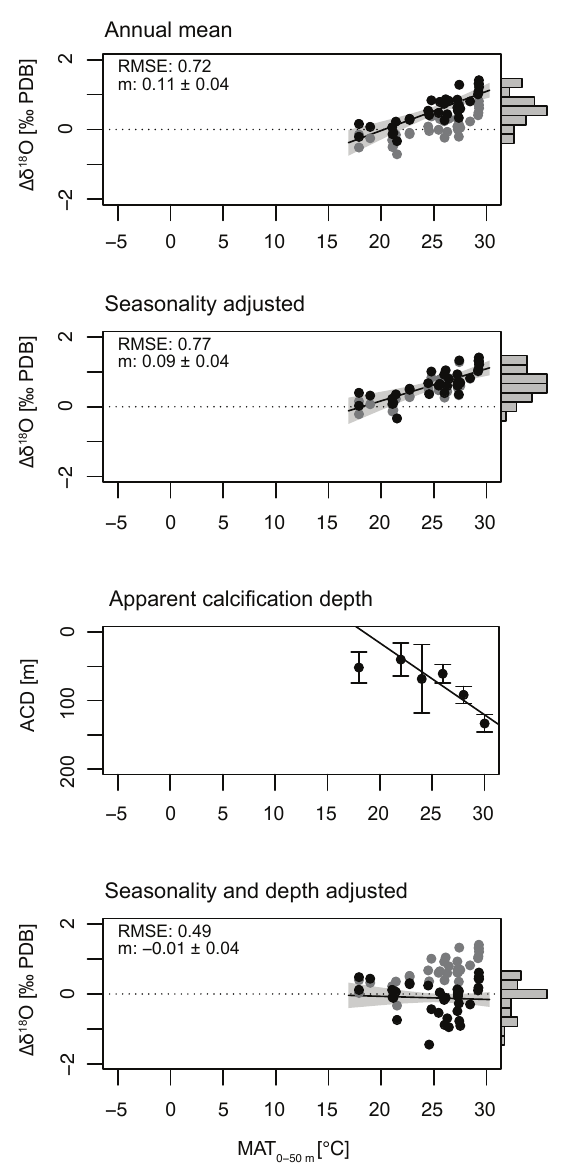
Figure 8. Assessing the effect of the use of a different palaeotem- perature equation. The panels show the same information as Figs. 2, 4, 5 and 6 respectively but for T. sacculifer and using the equation of Mulitza et al. (2003). Note that the basic patterns indicative of habi- tat tracking remain but that the general calcification depth appears greater, also at lower